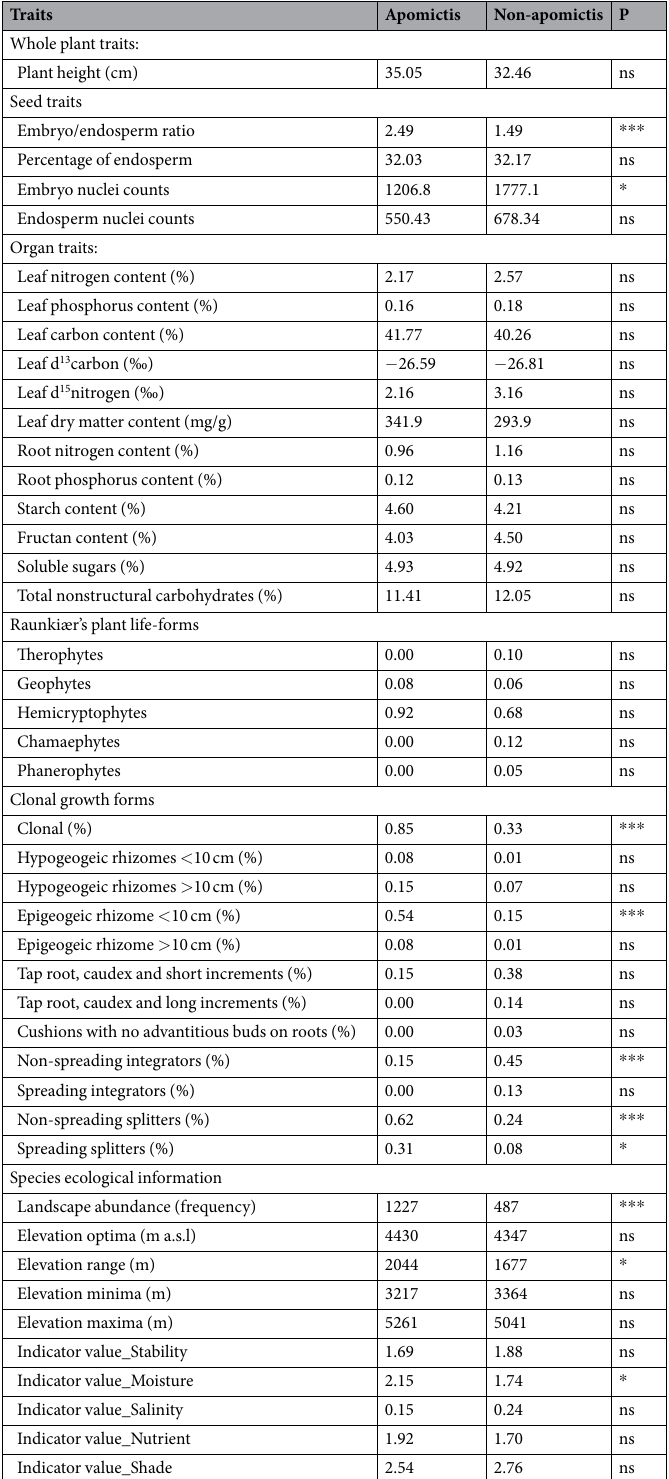
Table 1. List of plant functional traits and ecological indicator values measured on studied apomictic and non- apomictic species, their mean values and significant differences (ns, non-significant; * P < 0.05; ** P < 0.01; *** P <